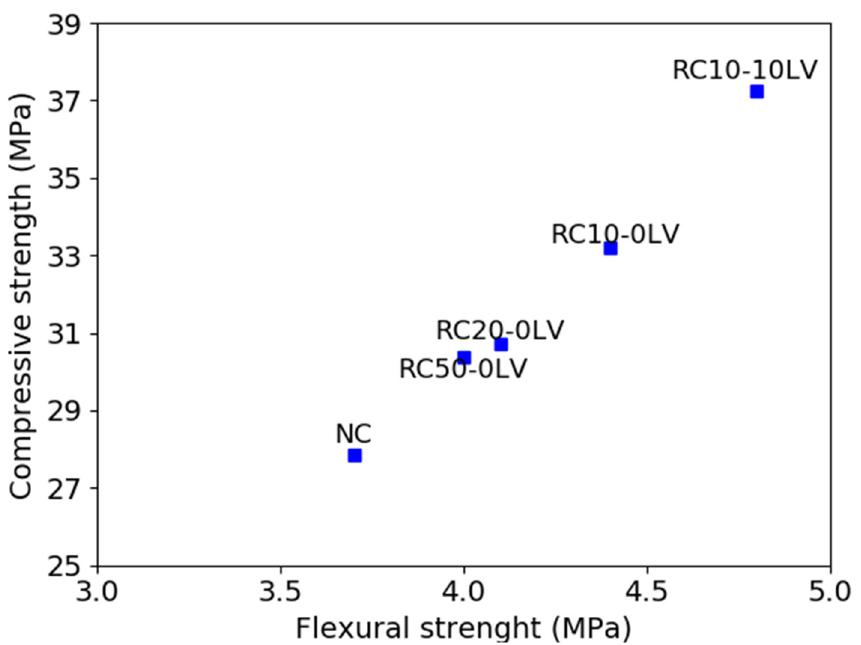
Figure 8. Flexural strength vs. Compression strength.